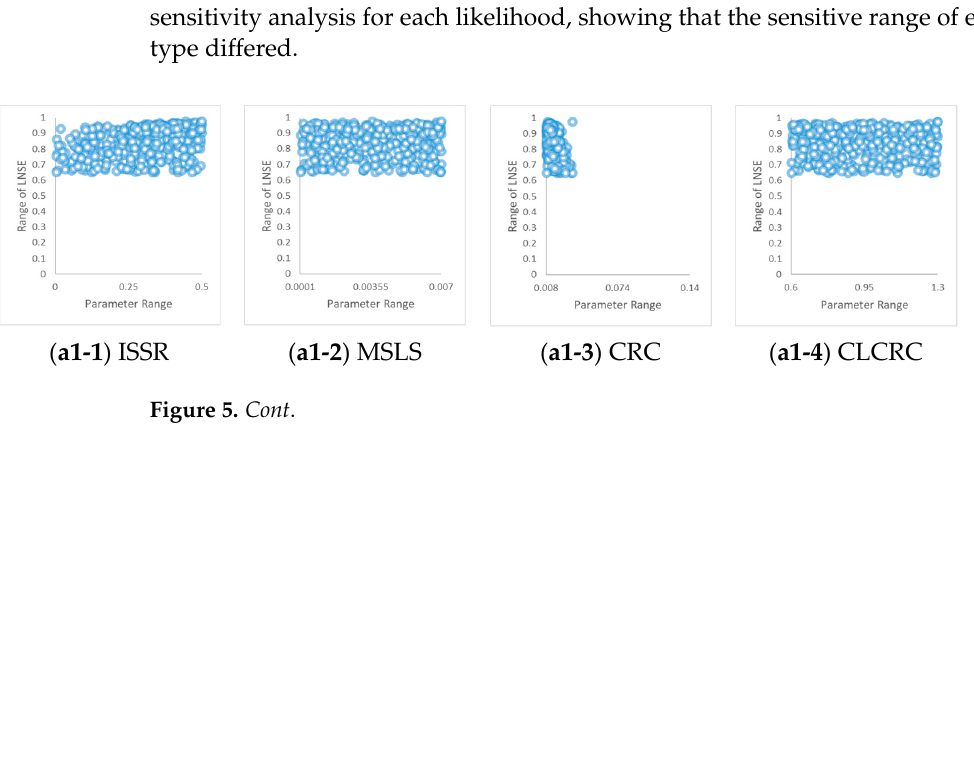
Table 3. GRM Parameters Description and